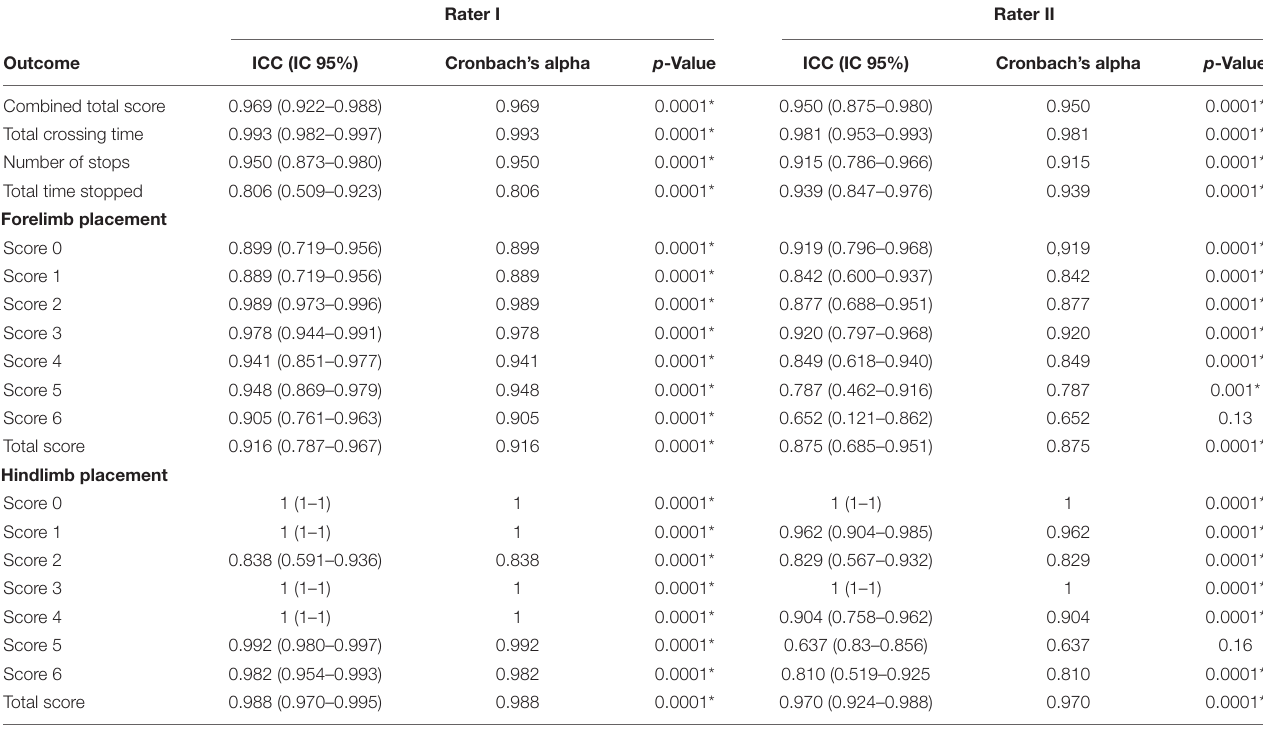
TABLE 4 | Intra-rater agreement on outcomes in the analyses of the LRWT in rats.